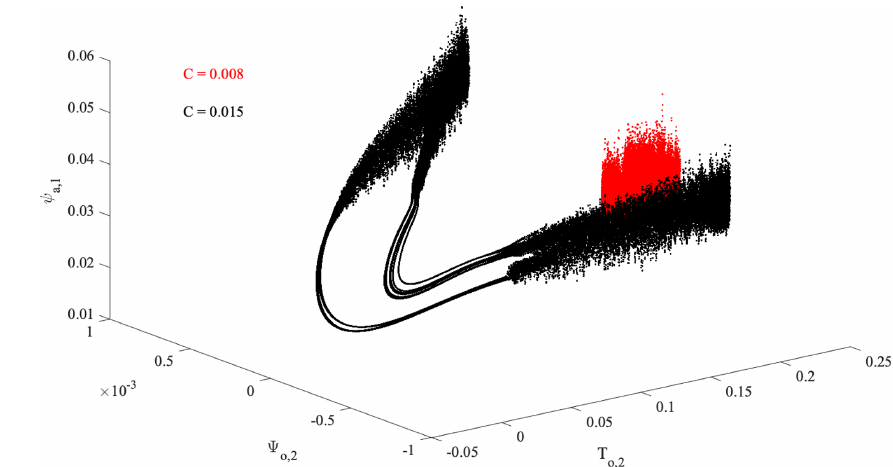
Figure 1. 3-D projection of the full system attractor in the subspace ( T o , 2 ,(cid:57) o , 2 ,ψ a , 1 ) for C = 0 . 008 (red) and C = 0 . 015 (black), respec-